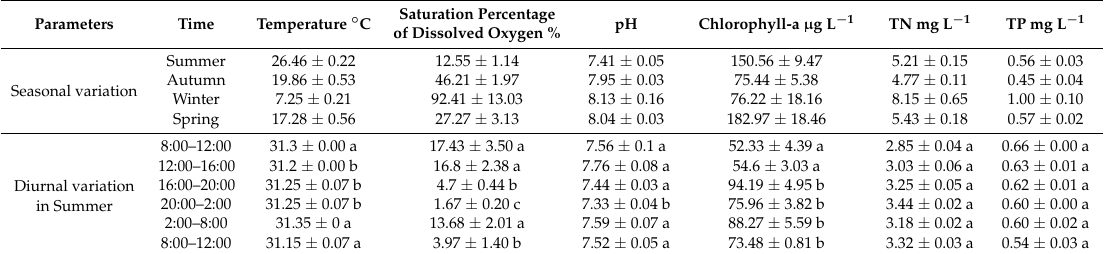
Table 3. The variation characteristics of water parameters during different investigating period. Parameters Time